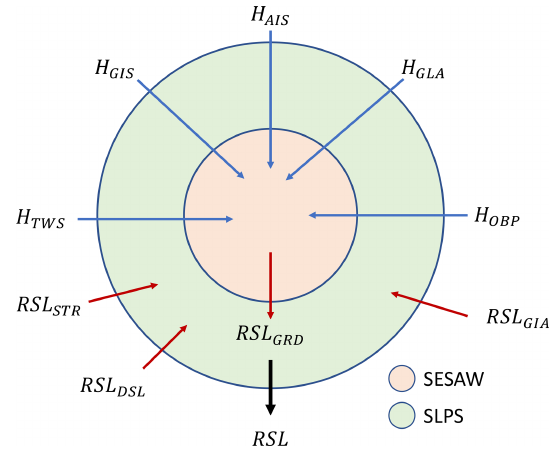
Figure 3. Diagram of ISSM’s Sea-Level Projection System (ISSM- SLPS) model. The system is driven by requirements from Eq. (2). ISSM-SESAW is the GRD core of the system (in pink). ISSM-SLPS is a combination of ISSM-SESAW and a layer (in green) that han- dles STR, DSL and GIA inputs, as well as all uncertainty quantifi- cation